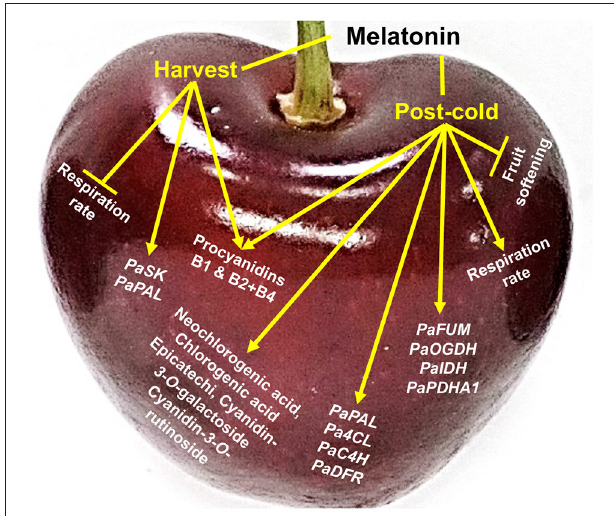
FIGURE 4 | Schematic presentation of the impact of melatonin in sweet cherries (cv. Ferrovia) at harvest stage (harvest) and following cold storage